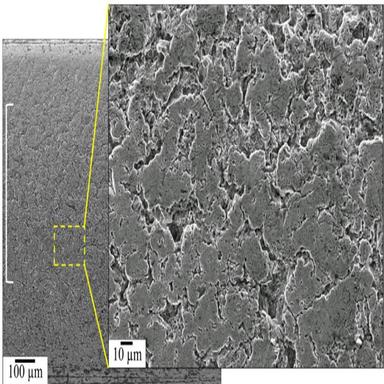
Erosion morphology at the tip of the leading edge (1H5 zone).